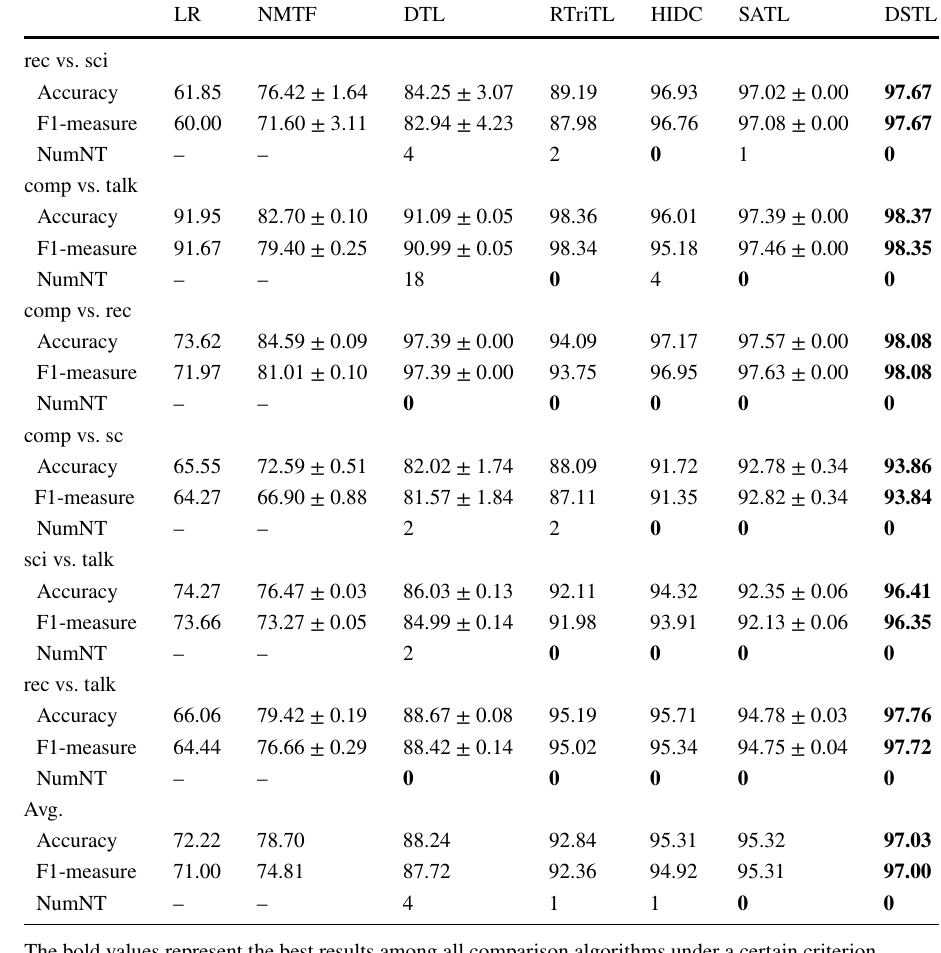
Table 6 The average effect (%) on 12 sentiment tasks